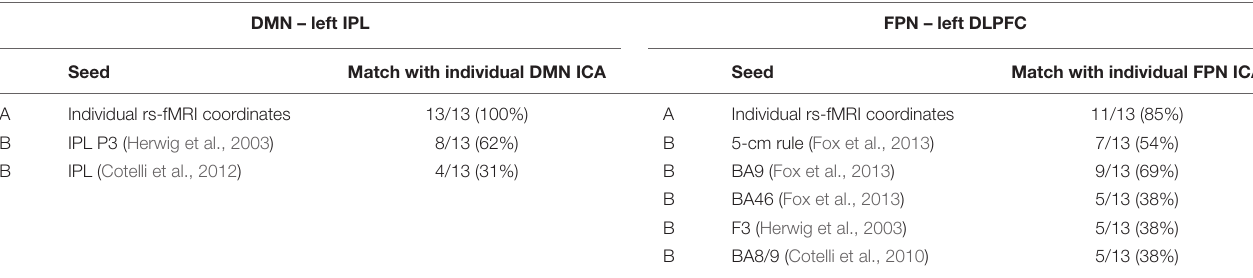
TABLE 5 | Correspondence between the individual ICA maps of the DMN and FPN and the seed connectivity maps obtained using (A) the individual TMS targets or (B) the group-level coordinates as seeds. DMN – left IPL FPN – left DLPFC